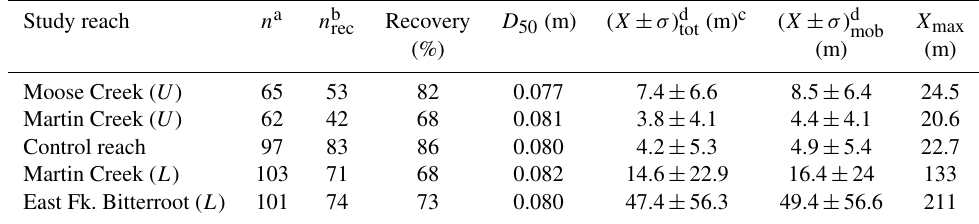
Table 2. Tracer recovery and transport statistics by study reach. Study reach n a n b rec Recovery D 50 (m) Moose Creek ( U ) 65 53 Martin Creek ( U )